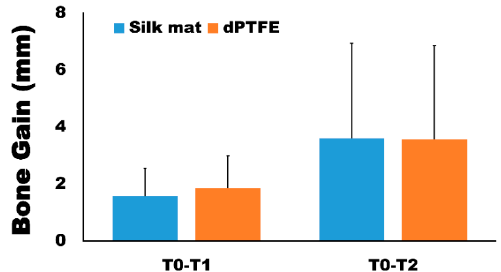
Figure 3. The amount of bone gain (BG) at three months (T1) and six months after tooth extraction (T2) compared to before tooth extraction (T0). There was no significant difference in BG between the silk mat and dPTFE groups at T1 and T2 ( p >